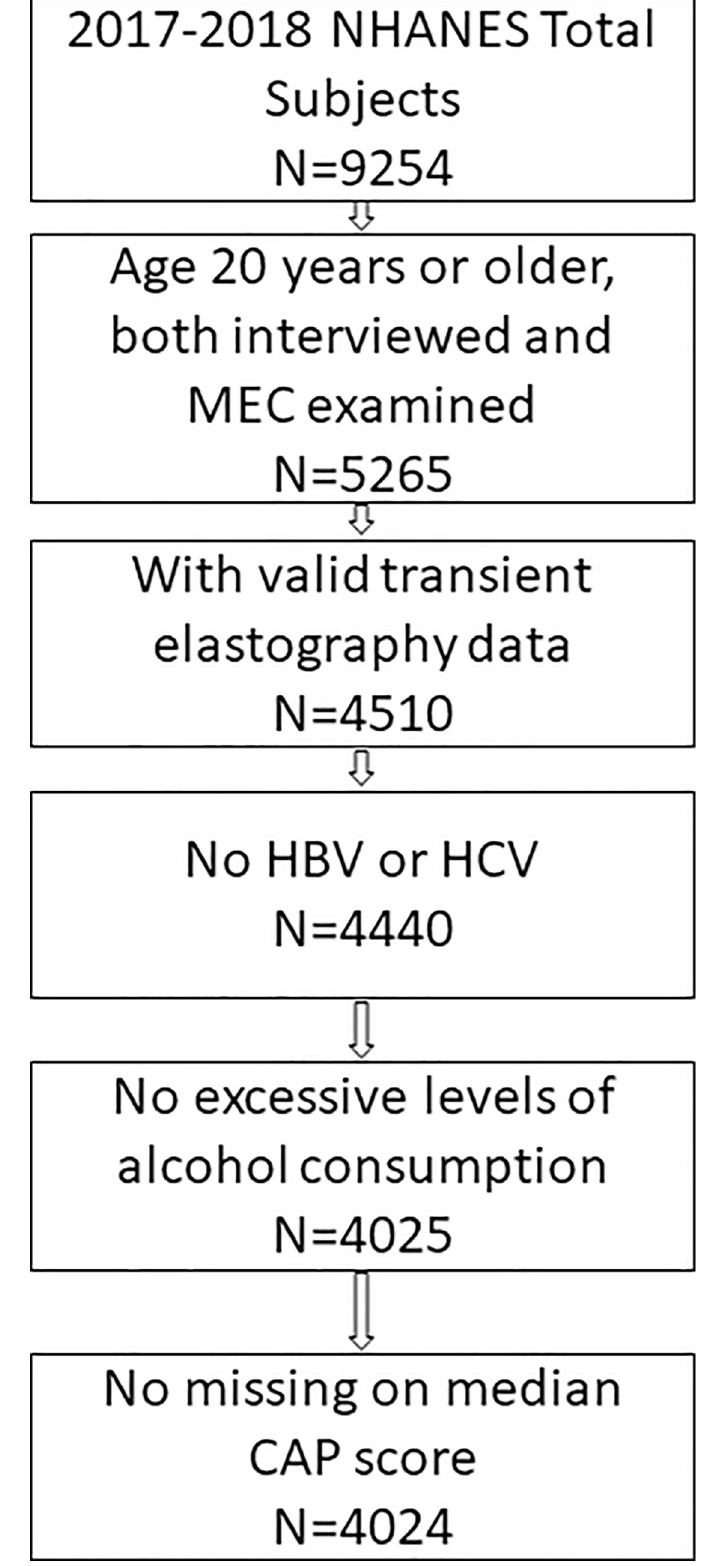
Fig 1. Flow chart for study population